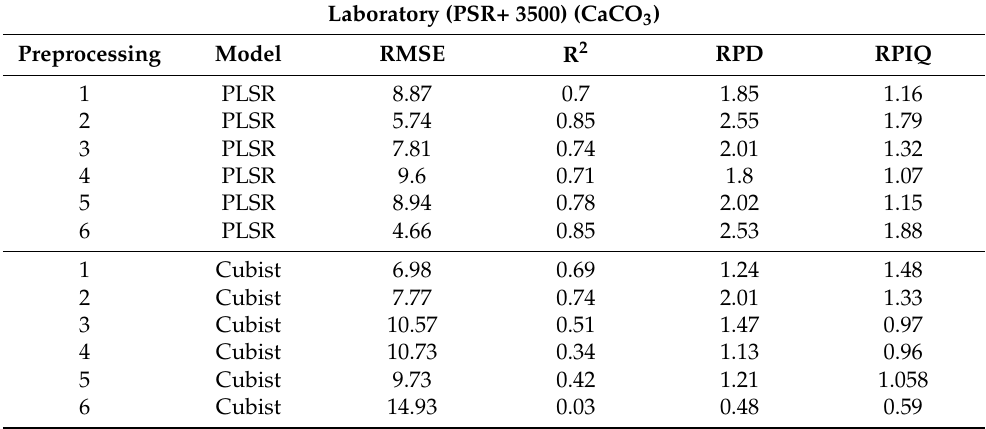
Table A4. Statistical evaluation of the models used to predict the calcium carbonate content (CaCO 3 ) from the laboratory